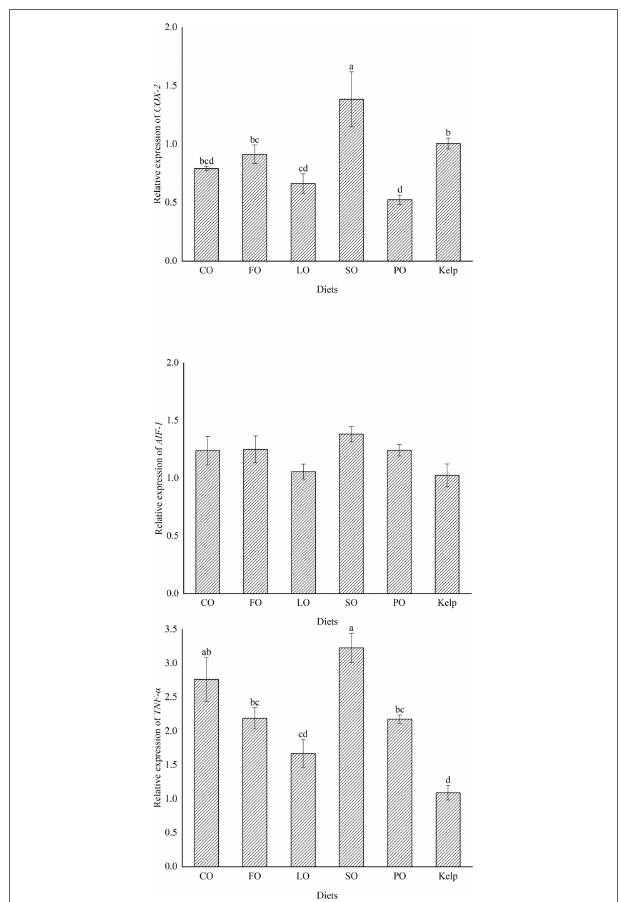
FIGURE 3 | Effects of dietary lipid sources (colza oil (CO), fish oil (FO), linseed oil (LO), soybean oil (SO), or palm oil (PO)) on the inflammatory related gene expression in the ovary of sea urchin ( Strongylocentrotus intermedius ) (mean ± SEM, n=3). COX-2 , cyclooxygenase-2. AIF-1 , allograft inflammatory factor-1. TNF- α , tumor necrosis factor- α . Mean value bars bearing with different lowercase letters are significantly different at P <